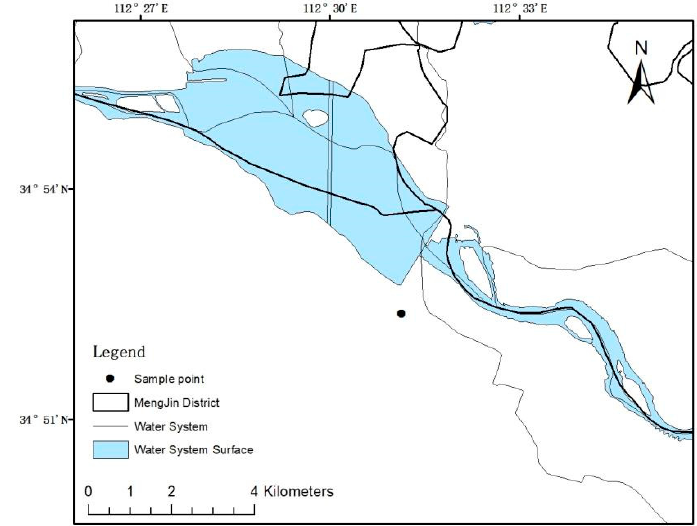
Figure 1. Location of sampling points.